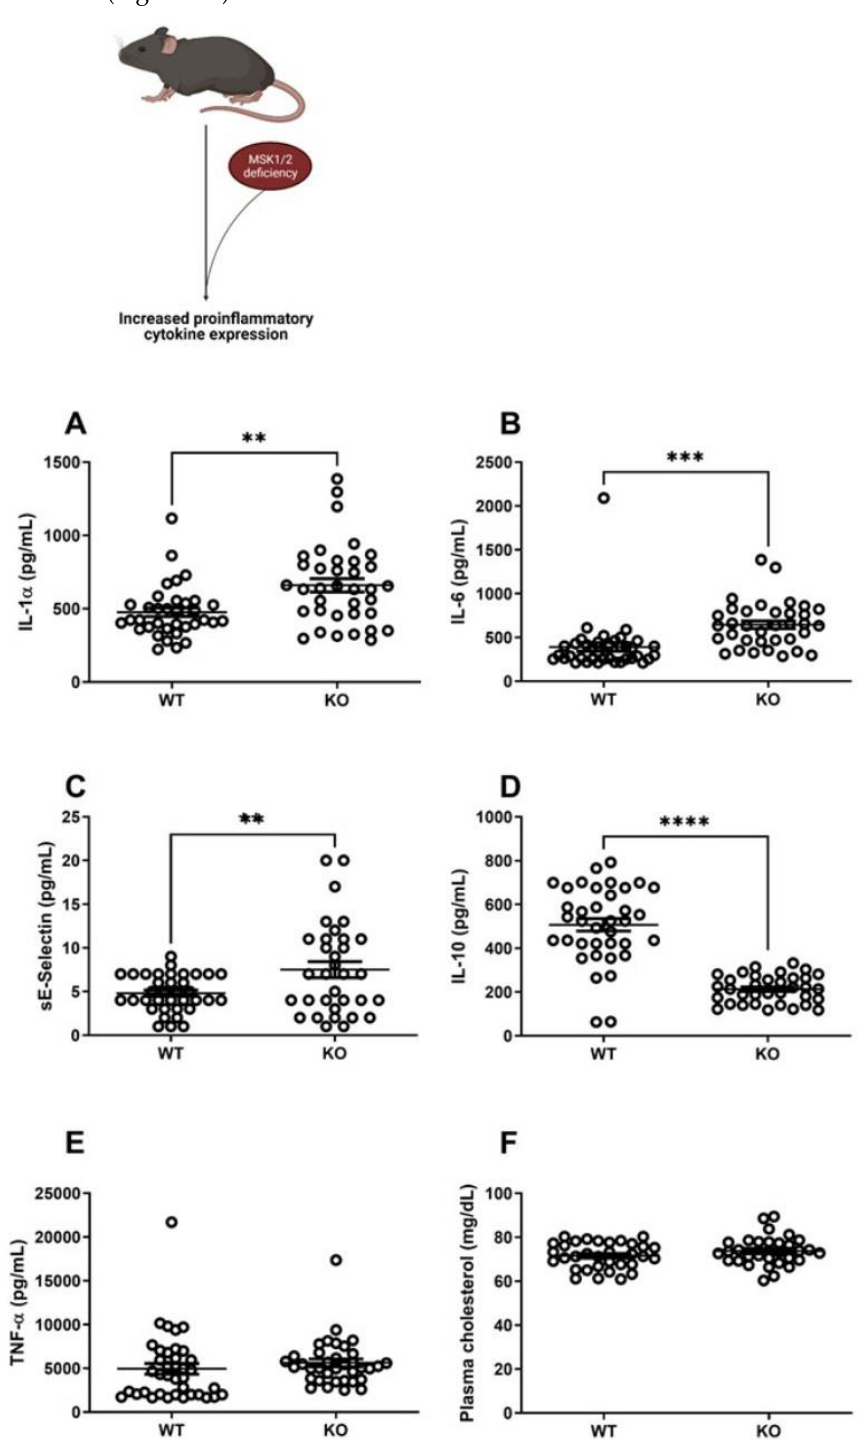
Figure 2. Plasma cytokine and cholesterol measurements in MSK1/2 knock-out (KO) and wild-type (WT) mice. ( n = 36) wild-type and MSK1/2 knock-out ( n = 38). Plasma levels of inflammatory markers in mice (pg/mL) at study baseline: ( A ) IL-1 α , ( B ) IL-6, ( C ) sE-Selectin, ( D ) IL-10, ( E ) TNF- α , ( F ) total plasma cholesterol (mg/dL). Values are group mean ± SE. ( A – F ) Unpaired T -tests. ** p < 0.01, *** p < 0.001, **** p <